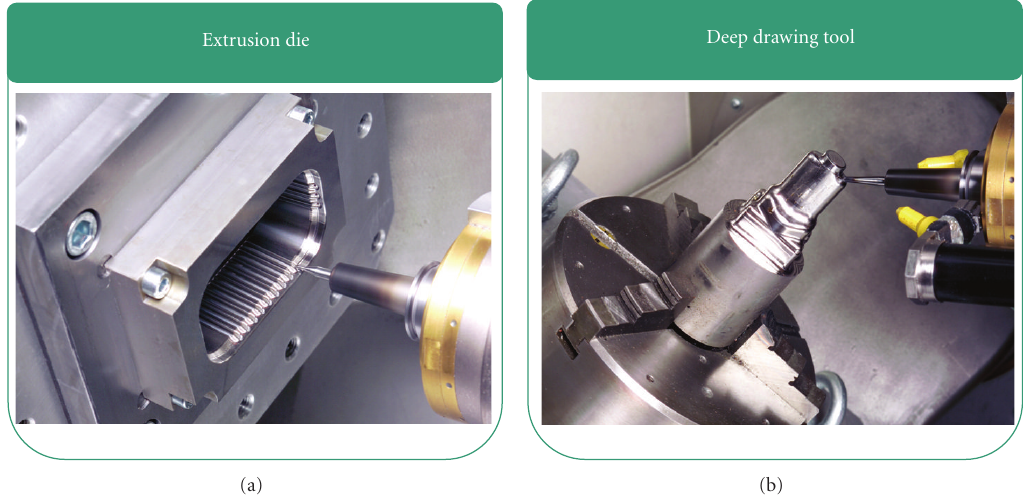
Figure 1: Tool and die making as a representative area of application for 5-axis-milling of superhard steels; (a) Heading tool; (b) Deep drawing